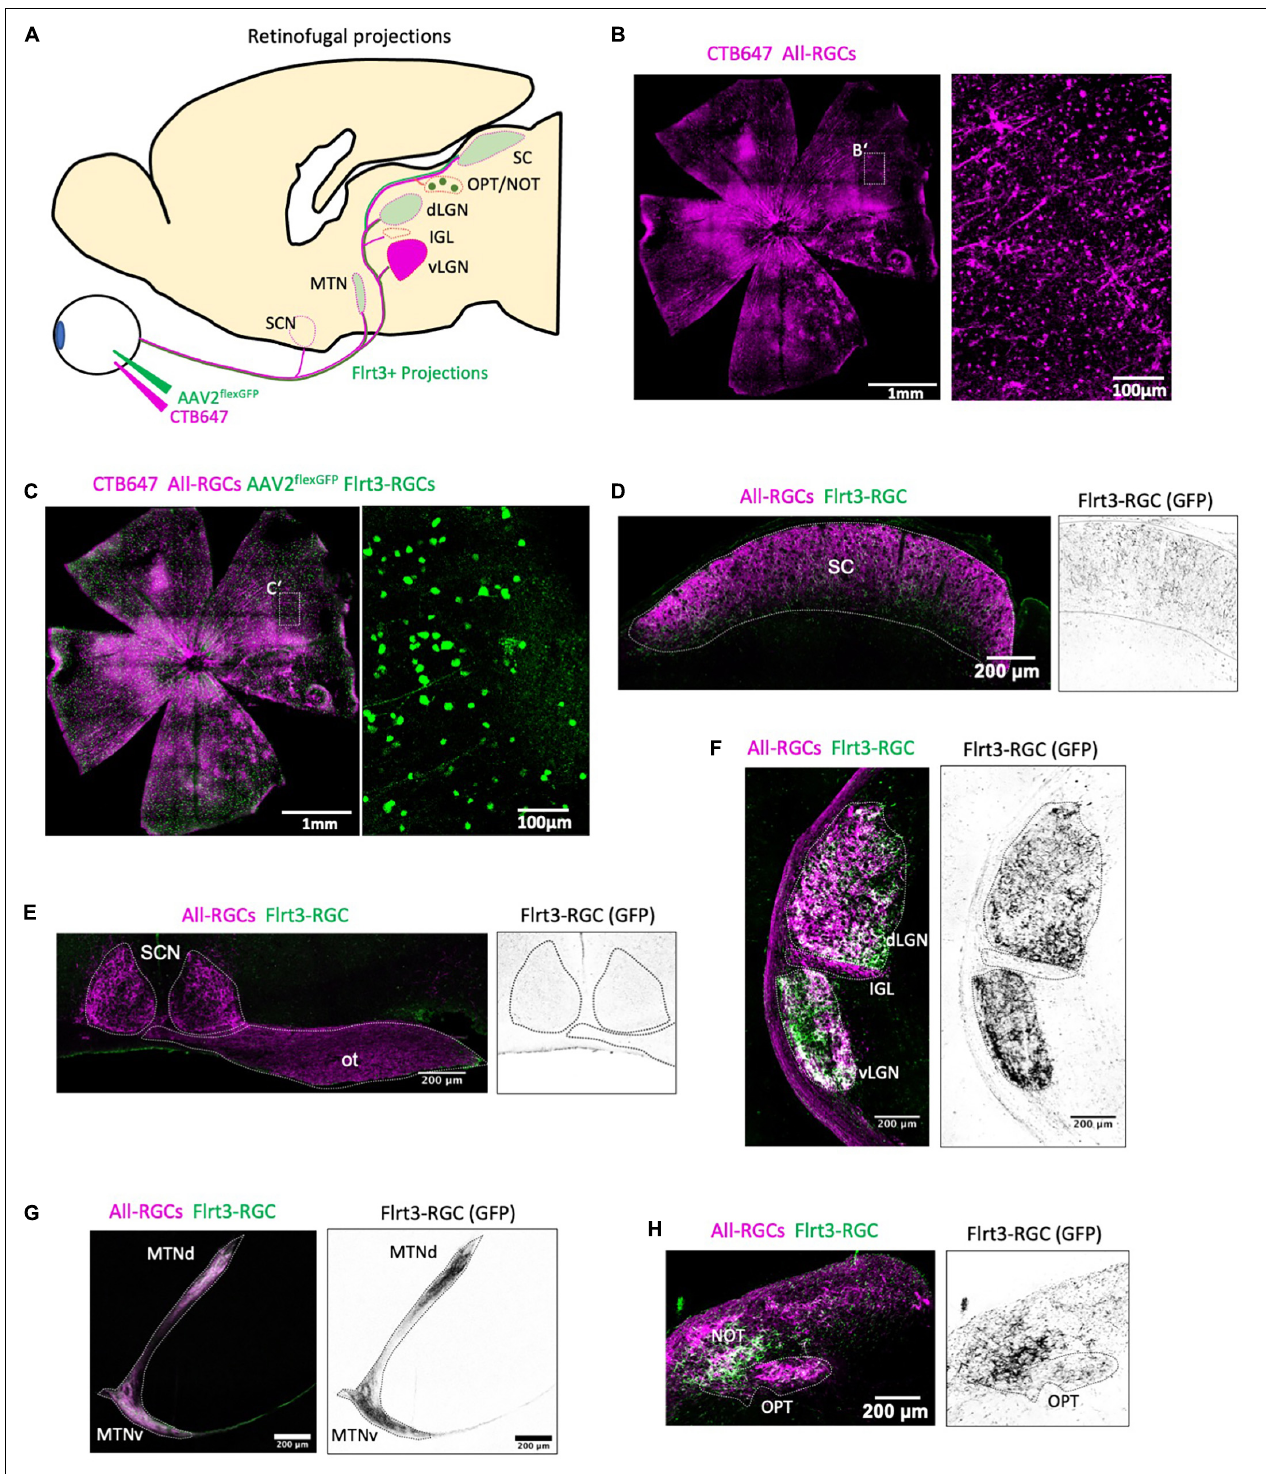
FIGURE 4 | Flrt3-RGCs projections in the mouse brain. (A) Scheme showing intravitreal injection of CTB647 and the cre-dependent AAV2-flex-GFP virus in Flrt3-CreERT2 mice. Representative images from one animal. (B,C) Representative whole mount retinas showing CTB647 labeled RGCs (magenta) and GFP expressing RGCs (green). (B) Shows an overlay of CTB647 and GFP. The right panel shows a zoom from each of (B’,C’) , respectively. (D–H) Specific projections of Flrt3 RGCs (green) and all RGC (magenta) axons in the (D) superior colliculus (SC), (E) SCN and optic tract (ot), (F) dLGN, IGL and vLGN, (G) MTN, (H) NOT and